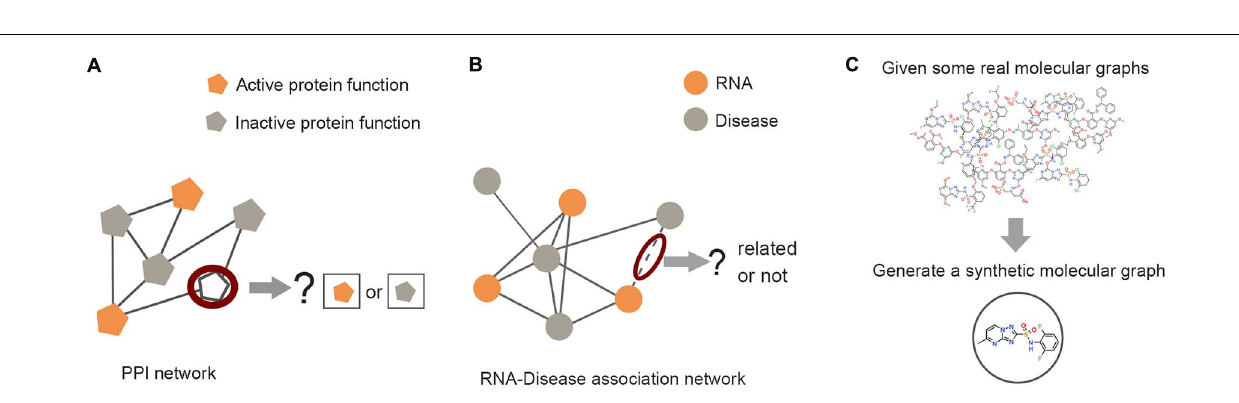
FIGURE 5 | Examples of graph analysis tasks in three levels. (A) Node level: the prediction of unlabeled proteins through labeled proteins in the protein–protein interaction network. (B) Edge level: predicting the unknown link between RNA nodes and disease nodes through the RNA–disease association network. (C) Graph level: the generation of synthetic molecules through actual molecular graph